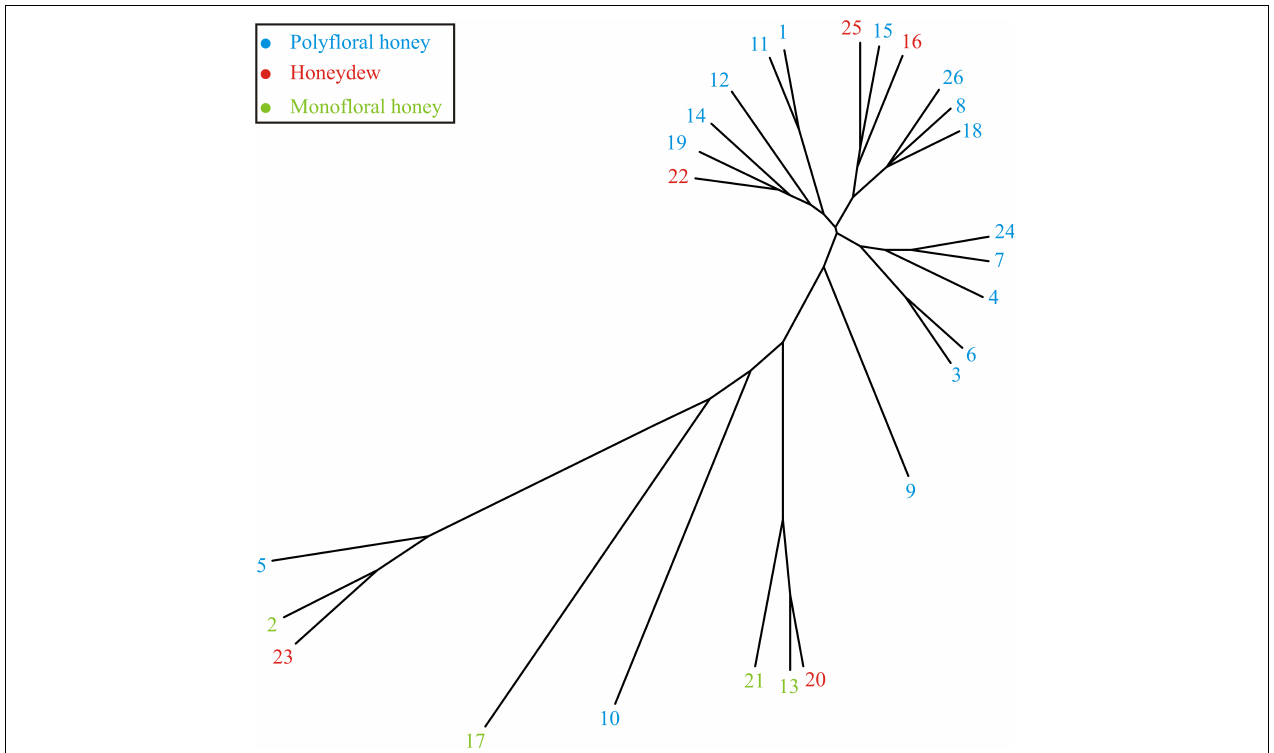
FIGURE 3 | The unrooted phylogenetic tree based on the melissopalynological analyses results presented in Table 4 .